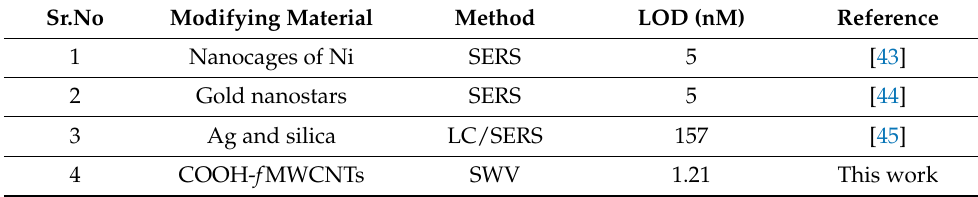
Table 1. Assessment of the performance of the designed and reported sensors.